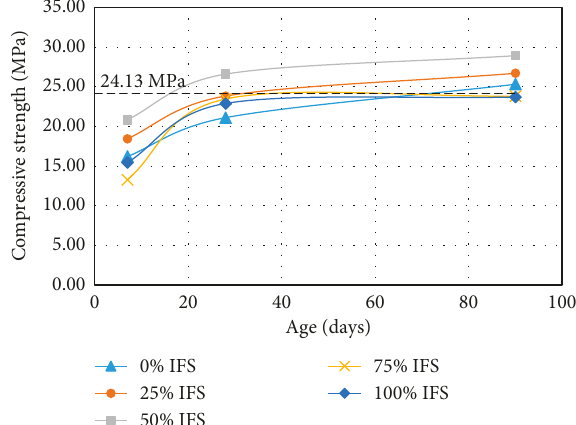
Figure 14: Compressive strength with days for different IFS ratio (target strength: 24.13MPa).